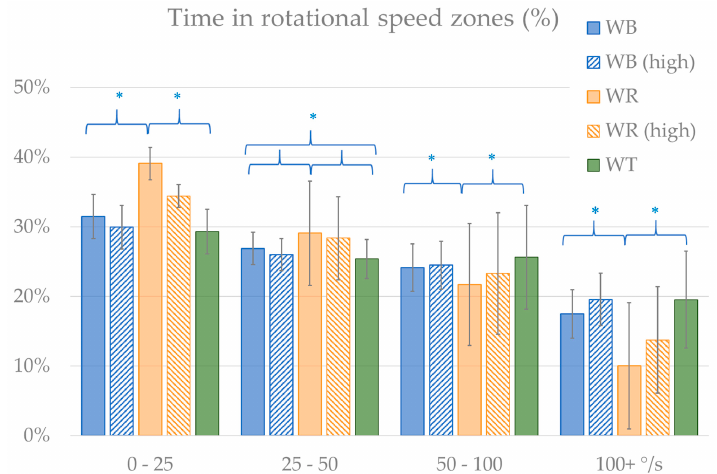
Figure 5. Distribution of time spent in rotational speed zones, with significant (p<0.05) differences marked (*).